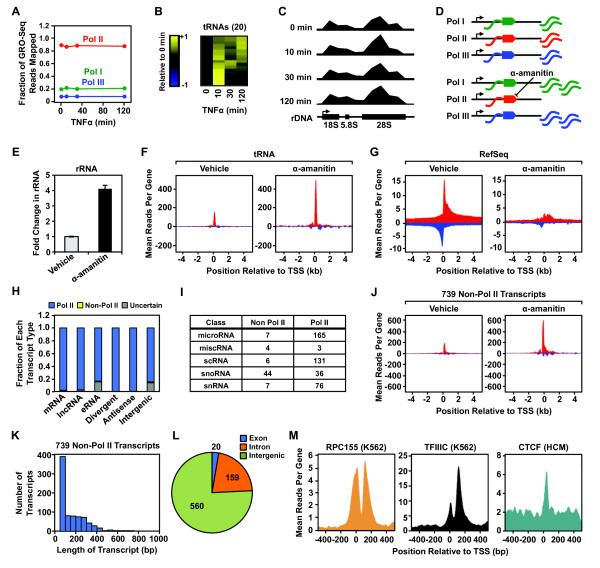
Pol I, II, and III transcription in AC16 cells in response to TNFα. AC16 cell nuclei were treated with α-amanitin for 15 min. prior to GRO-seq analysis. The final read density for each gene was normalized to the total reads obtained in each condition. A) Effect of TNFα on the fraction of GRO-seq reads mapped to rDNA repeats (Pol I; green line), RefSeq genes (Pol II; red line), and tRNA genes (Pol III; blue line) over the time course of TNFα treatment. B) Heatmap showing the expression of 20 tRNA transcripts upregulated during a time course of TNFα treatment. C) Browser track representation of GRO-seq reads mapped to rDNA repeats (GenBank U13369.1) in 1 kb bins over a time course of TNFα treatment. D) Scheme for the GRO-seq experiments with α-amanitin showing the expected effects on Pol I, II, and III transcription. E) Relative change in GRO-seq reads at rDNA repeats in control and α-amanitin-treated AC16 nuclei. F and G) Metagene representations of the average number of GRO-seq reads distributed around tRNA (F) and RefSeq (G) gene TSSs in control and α-amanitin-treated AC16 nuclei. H) Fraction of different types of uniquely mapped transcripts transcribed by Pol II or other RNA polymerases, as revealed by α-amanitin treatment. I) The number of annotated, short, non-coding transcripts transcribed by Pol II or other RNA polymerases, as revealed by α-amanitin treatment. J) Metagene representations of the average GRO-seq read distributions ± 4 kb around the TSSs of 739 non-Pol II transcripts identified using α-amanitin. K) Histogram showing the length distribution of all 739 non-Pol II transcripts from (J). L) Pie chart showing the genomic distribution of the genes encoding all 739 non-Pol II transcripts from (J). M) Metagene representations of the average ChIP-seq read distributions ± 500 bp around the TSSs for RPC155 (Pol III subunit) in K652 cells (left), TFIIIC in K562 cells (middle), and CTCF in human cardiomyocytes (HCM) (right) relative to the TSSs (± 500 bp) of the identified non-Pol II transcripts.